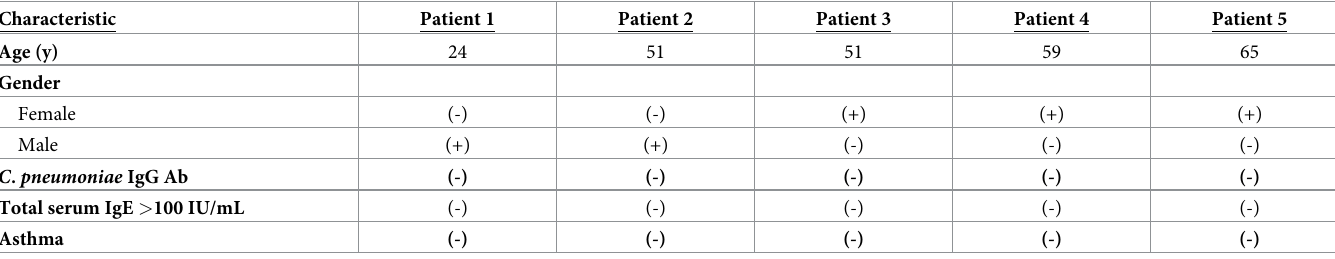
Table 1. Patient demographic and clinical characteristics.